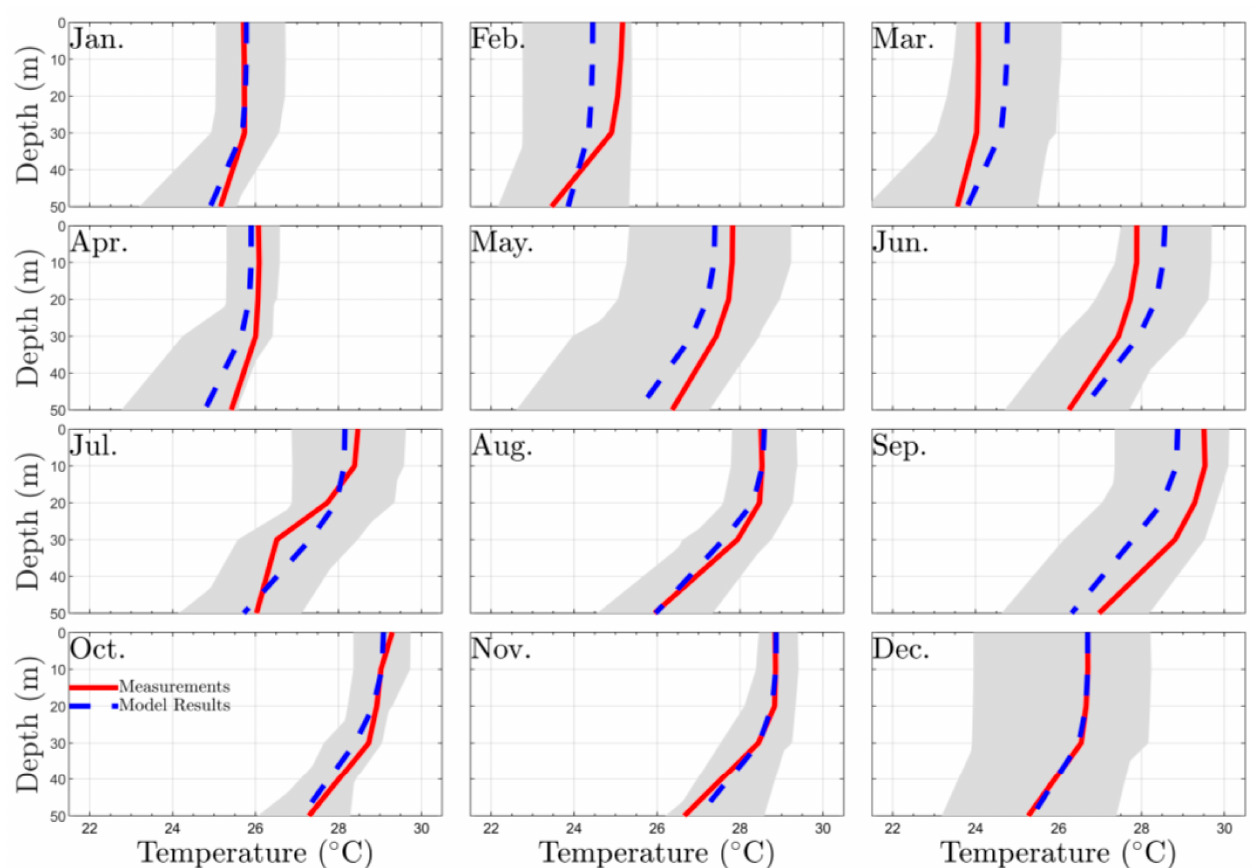
Figure 8. Comparison of the measured (red line) and simulated (dashed blue line) temperature profiles and model results for each month (shaded area). Temperature ranges by month (max–min):